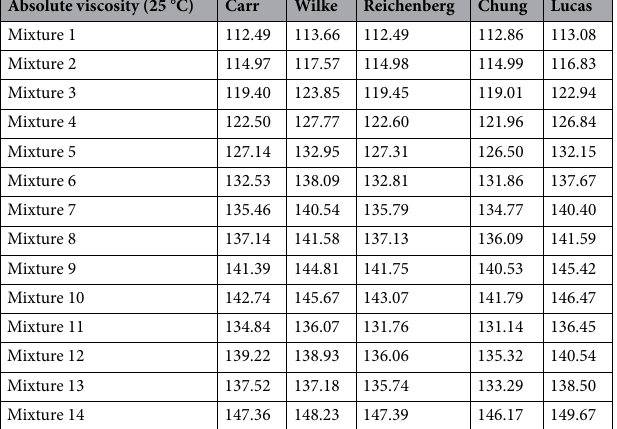
Table 4. Viscosity of the gas mixtures obtained with the five different models.